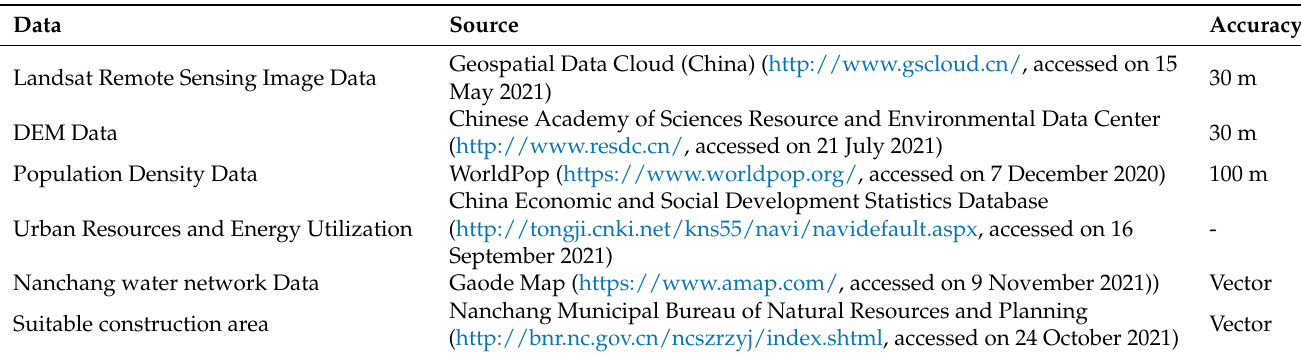
Table 1. Sources of study area